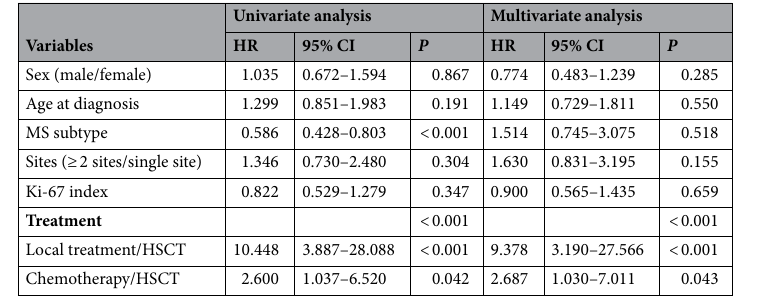
Table 5. Univariate and multivariate analyses of the 118 patients with MS. MS myeloid sarcoma, HSCT hematopoietic stem cell transplantation, HR hazard ratio, CI confidence